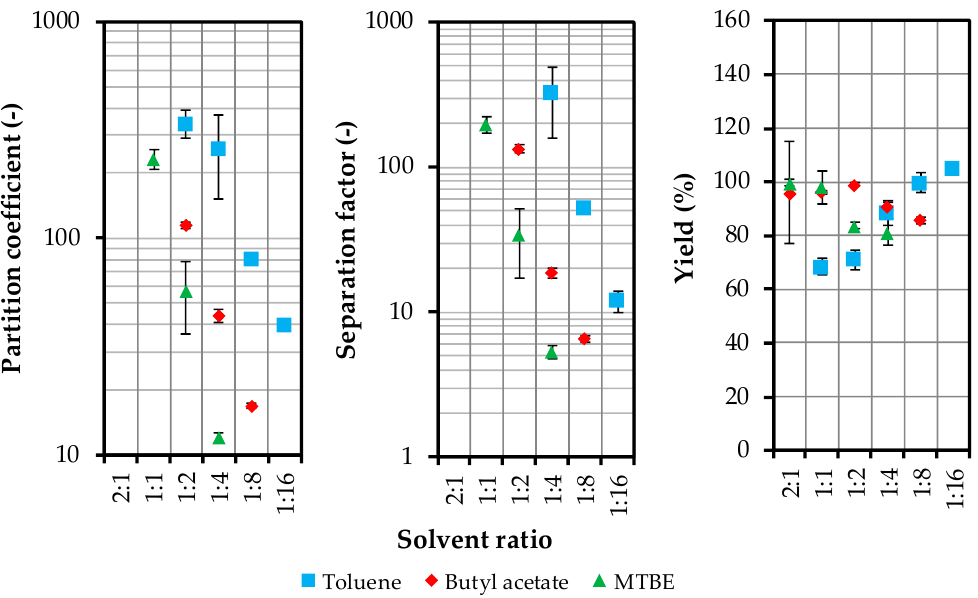
Figure 3. Distribution coefficient, separation factor and yield as a function of solvent ratio. MTBE (methyl tert-butyl ether).